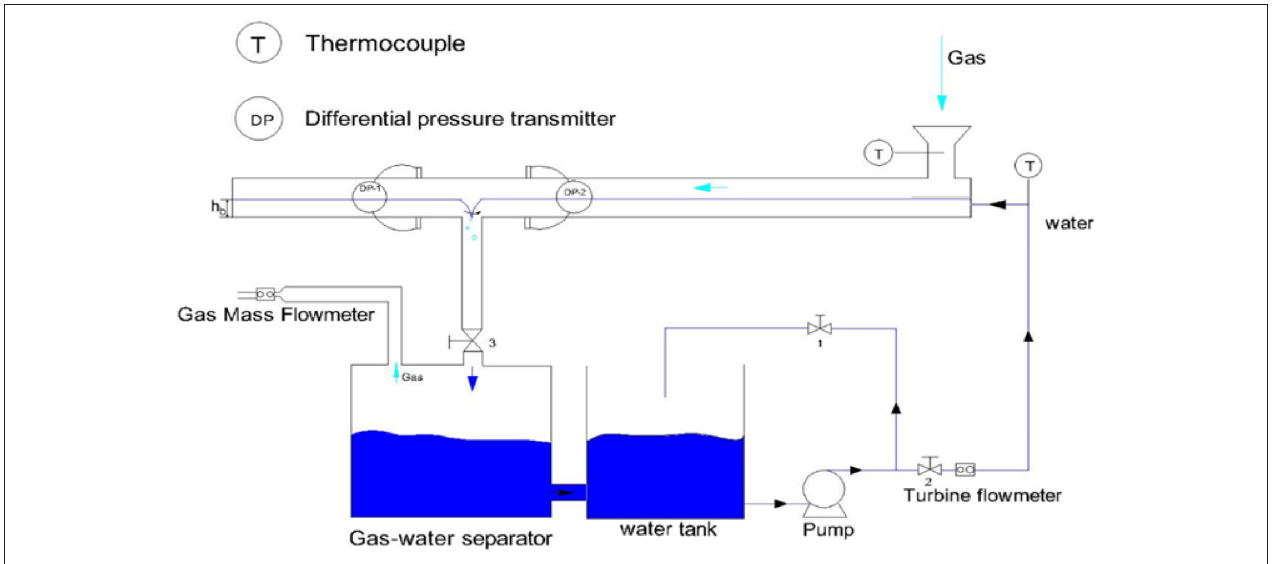
FIGURE 1 | Schematic diagram of the test